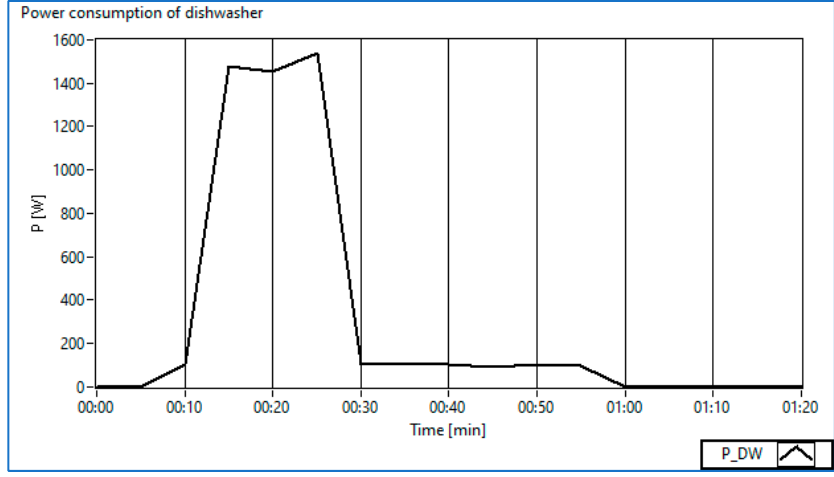
Figure 3. Power consumption (P_DW) during an operation cycle for dishwasher. Table 2. Washing-machine power consumption during the operating cycles.